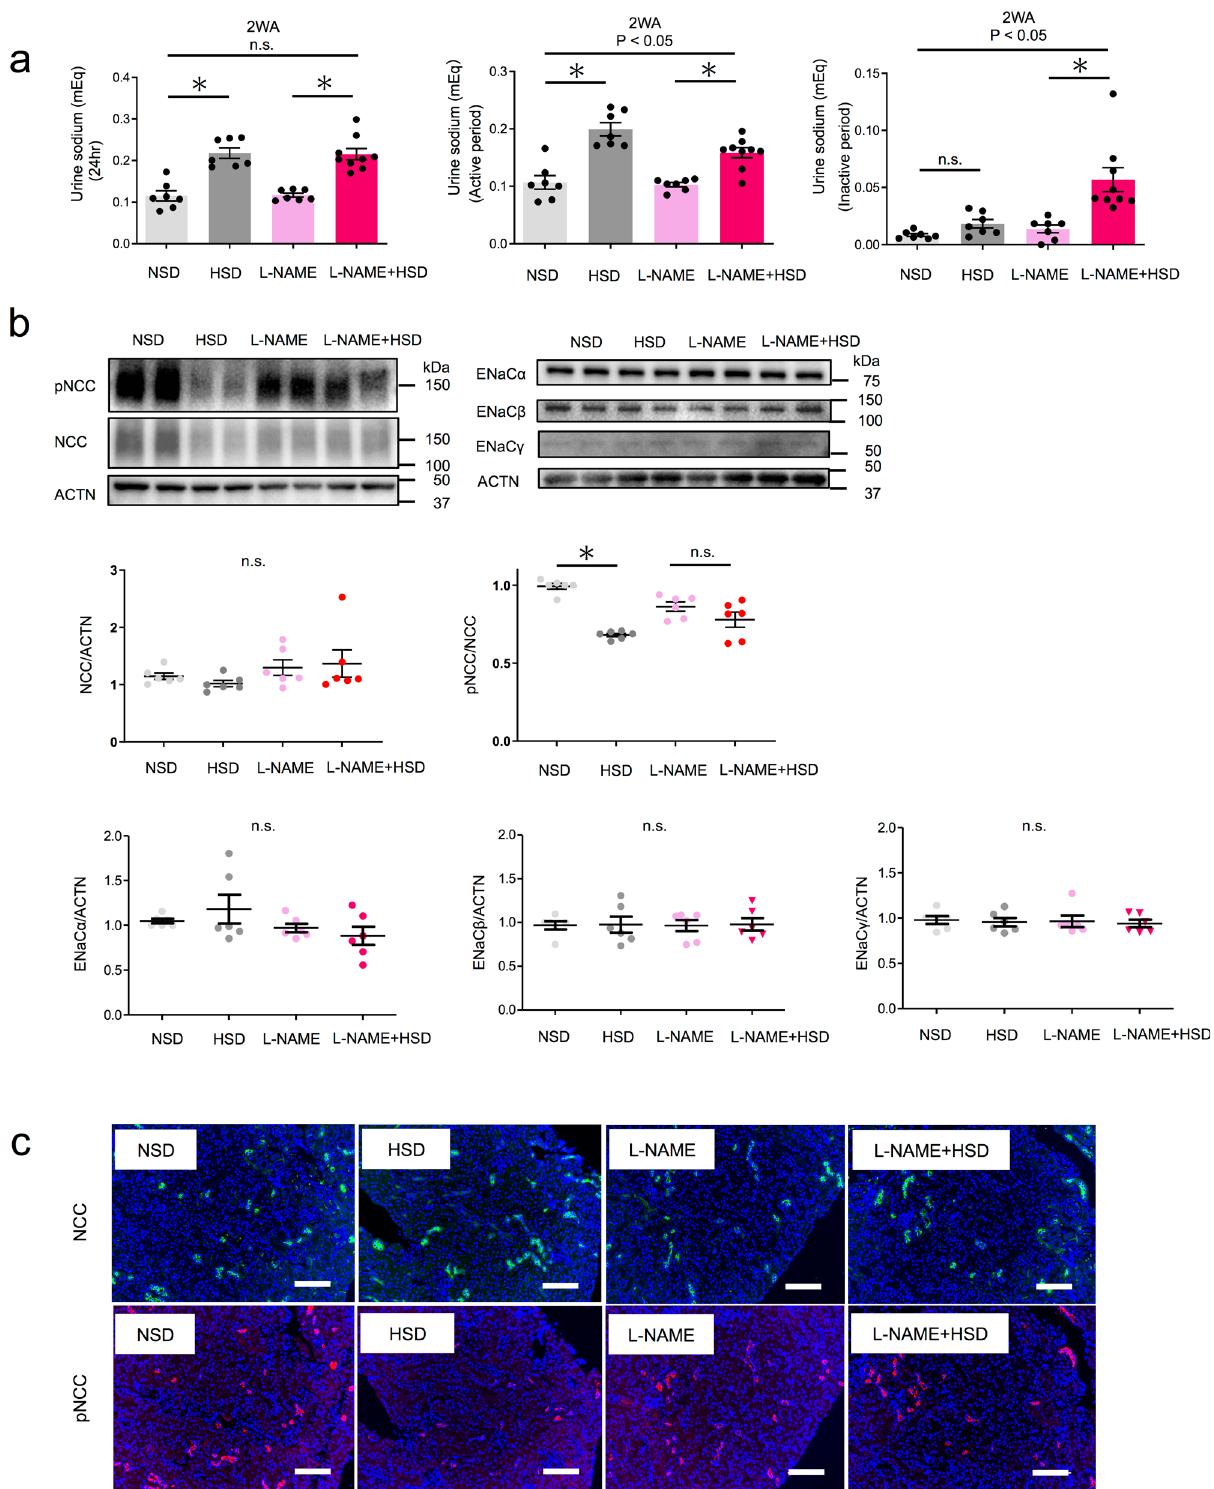
Fig. 3 Overactivation of NCC during the active period inhibits sodium excretion under NO suppression. a Urinary sodium excretion per day (left) during active (middle) and inactive (right) periods (NSD, HSD, L-NAME: n = 7, L -NAME + HSD: n = 9). Statistical analysis was performed using the two-way ANOVA or the two-tailed Student ’ s t -test. b Representative immunoblotting (above) and quantitative analysis (below) of renal phosphorylated NCC (pT53), NCC, ENaC α , ENaC β , ENaC γ , and ACTN in the active phase for the four groups. Data are expressed as the mean ± SEM. * p < 0.05 ( n = 6 mice per group). Statistical analysis was performed using two-way ANOVA. c Representative fl uorescent immunostaining of renal phosphorylated NCC (pT53) and total NCC for the four groups using serial sections. Original magni fi cation: ×200. Scale bar, 100 μ m. All data are expressed as the mean ± SEM, * p < 0.05.